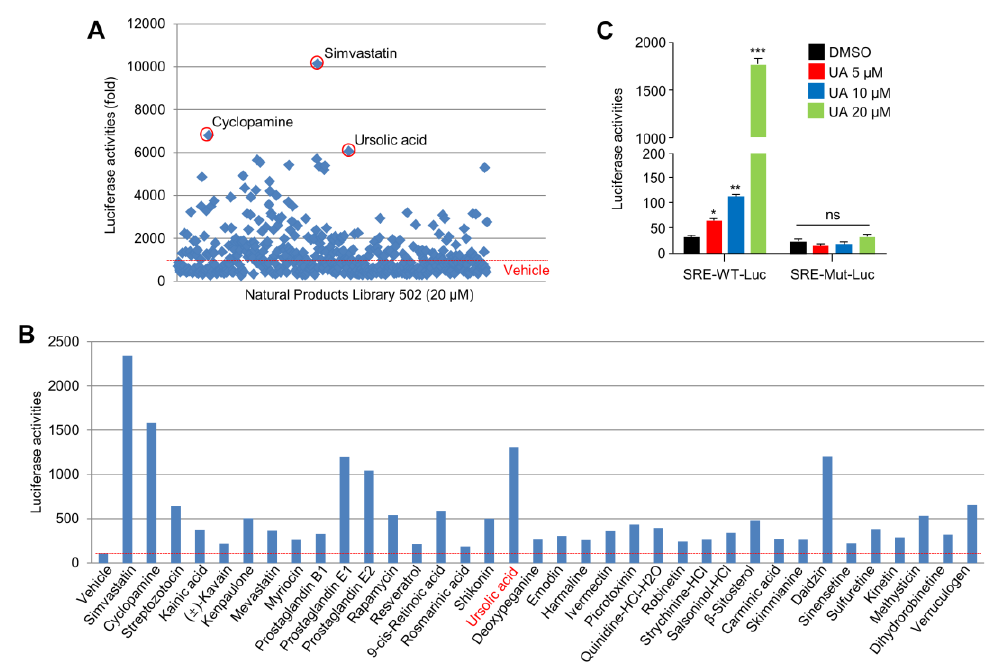
Figure 1. Luciferase assay-based screening for natural compounds that activate the sterol regulatory element-binding protein 2 (SREBP2). ( A ) Wild-type sterol regulatory element (SRE)-luciferase vector was transiently expressed in HEK293T cells, and incubated for 24 h with dimethyl sulfoxide (DMSO), as a negative control, or one of the 502 natural compounds. Each compound was dissolved in dimethyl sulfoxide (DMSO) and used at a final concentration of 20 µ M. The values represent the mean from the two independent experiments performed. ( B ) HEK293T cells expressing SRE-luciferase vector were incubated for 24 h with 25 of the 502 library compounds, selected during the first screening. Simvastatin (20 µ M) was used as a positive control and DMSO (vehicle) was used as a negative control. The values represent the mean from two independent experiments performed in triplicate. ( C ) SK-HEP-1 cells expressing SRE-WT (wild type of SRE) or SRE-MT (mutant of SRE)-luciferase vector were incubated for 24 h with ursolic acid (UA) at di ff erent concentrations, as indicated. The values represent the mean ± SD of three independent experiments performed in triplicate; * p < 0.05, ** p < 0.01, and *** p < 0.001.